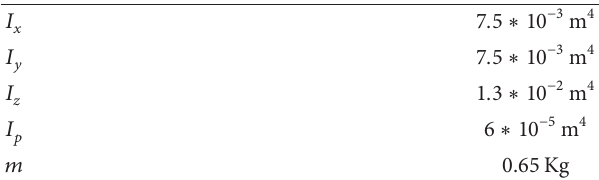
Table 1: Looping